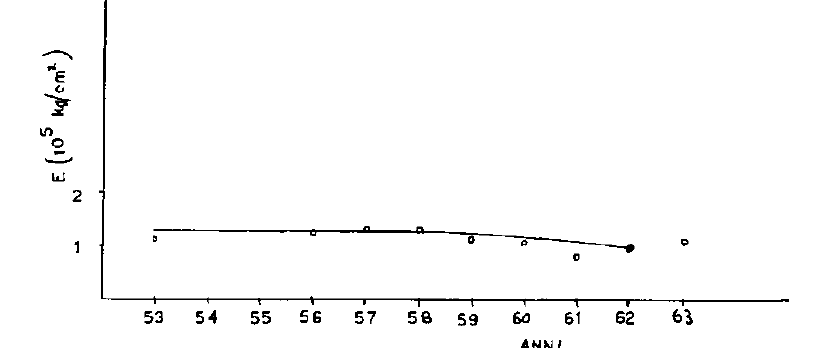
Fig. 1 - Diga di Pieve di Cadore. - Decadimento del modulo di elasticità per un tragitto in Spalla